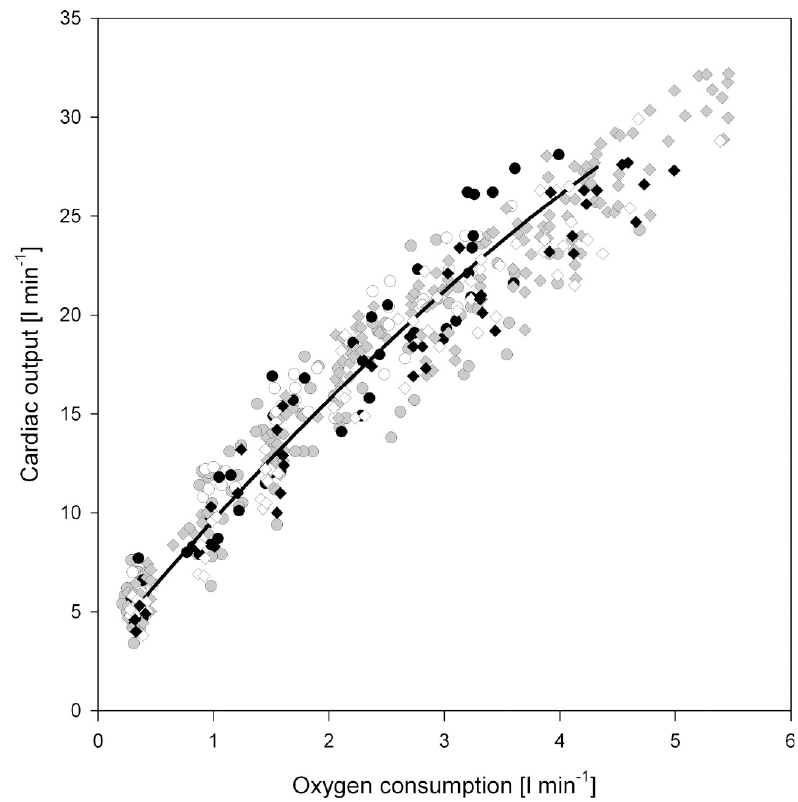
. V O 2 . Taken with